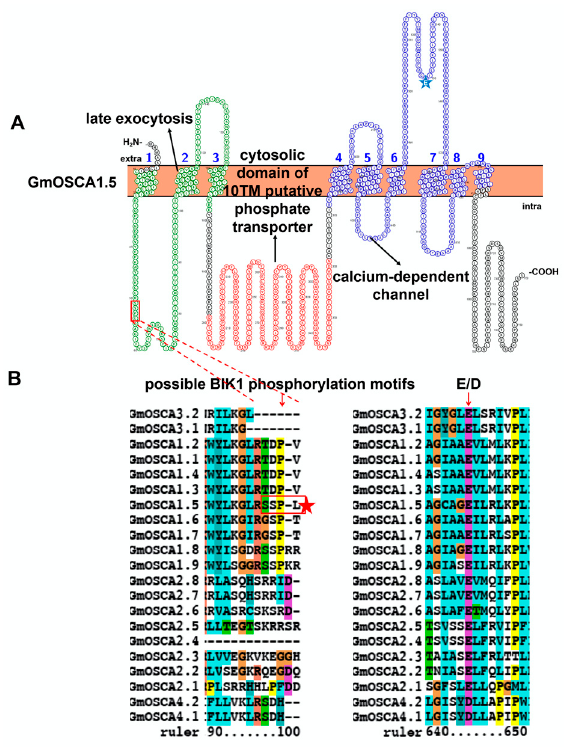
Figure 7. Topology model ( A ) and homology analysis ( B ) of soybean hyperosmolality-gated calcium-permeable channel (OSCA). The red box in the topology model represents the possible BIK1 phosphorylation motif, which is marked with a red box and a red star in the protein sequence alignment. The blue star indicates the conserved Asp or Glu in the calcium-dependent channel domain. The protein topology figure was constructed by using Protter [25]. The protein sequences were aligned by using ClustalX1.83 (http://www.clustal.org/download/, accessed on 17 October 2022).